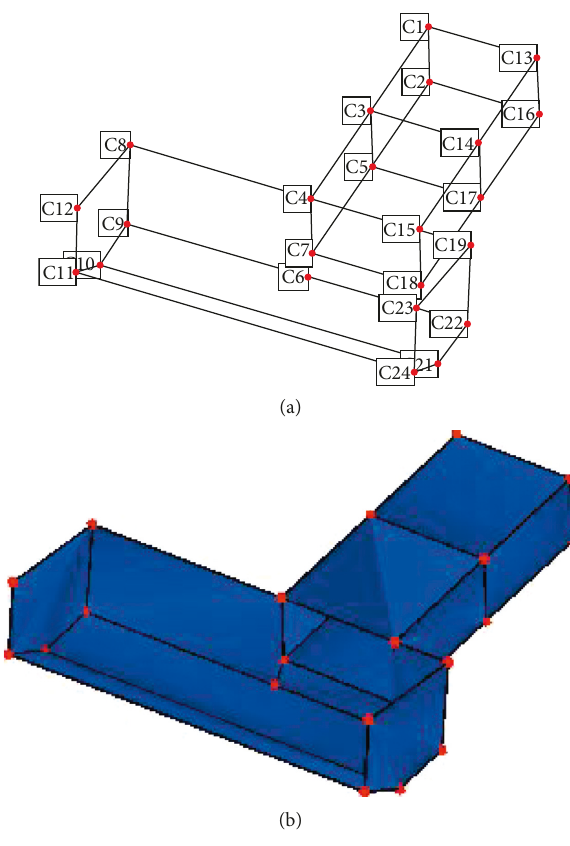
Figure 14: Frame model of header platform and conveyer house. (a) Line model. (b) Contour model.